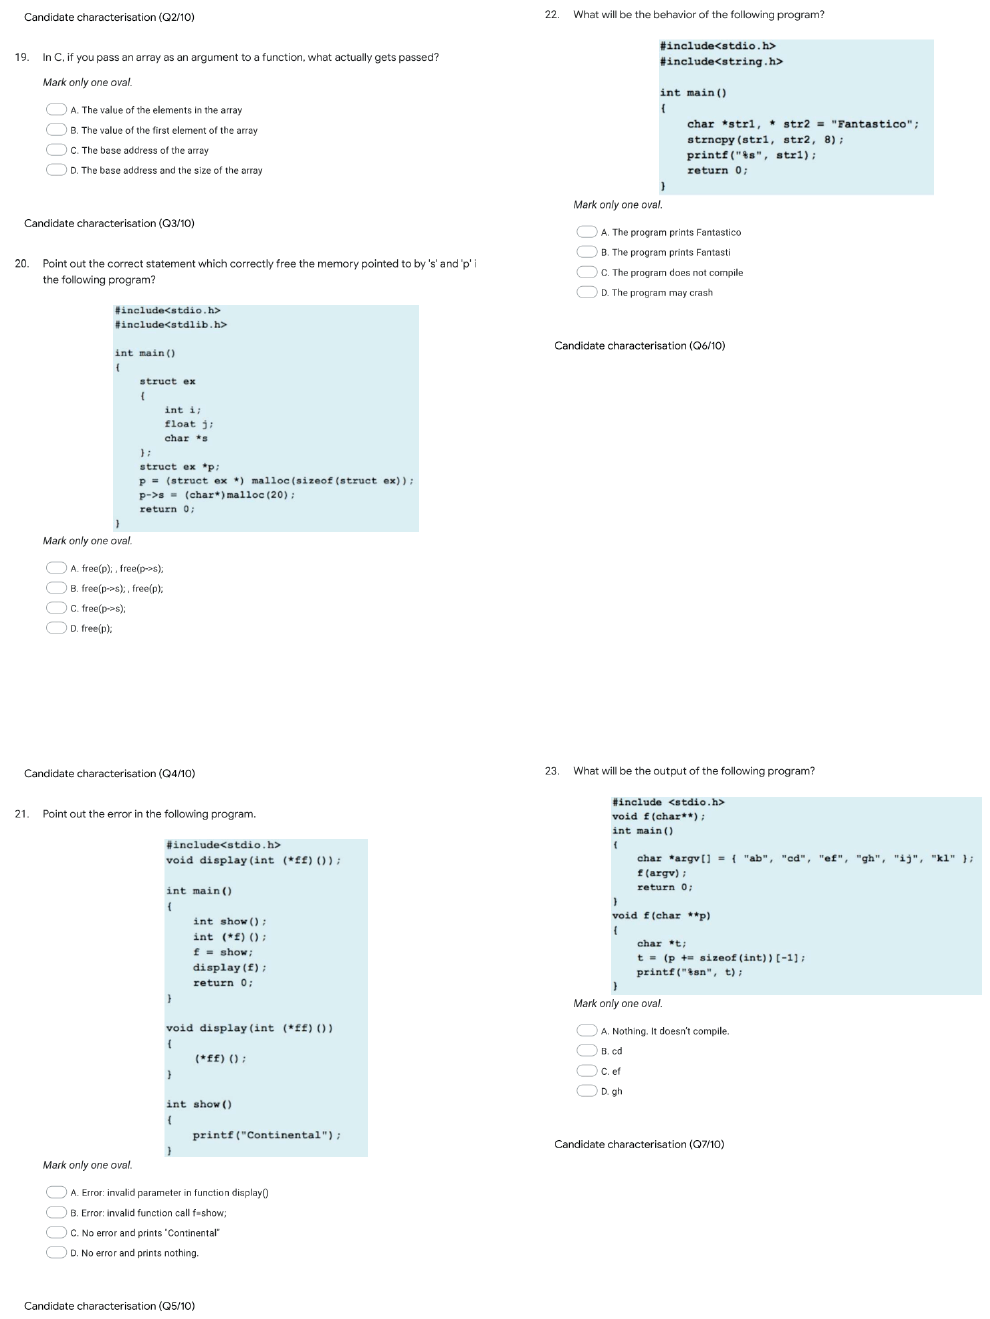
Figure A2. Technical questionnaire subpart (question 19 to 23).